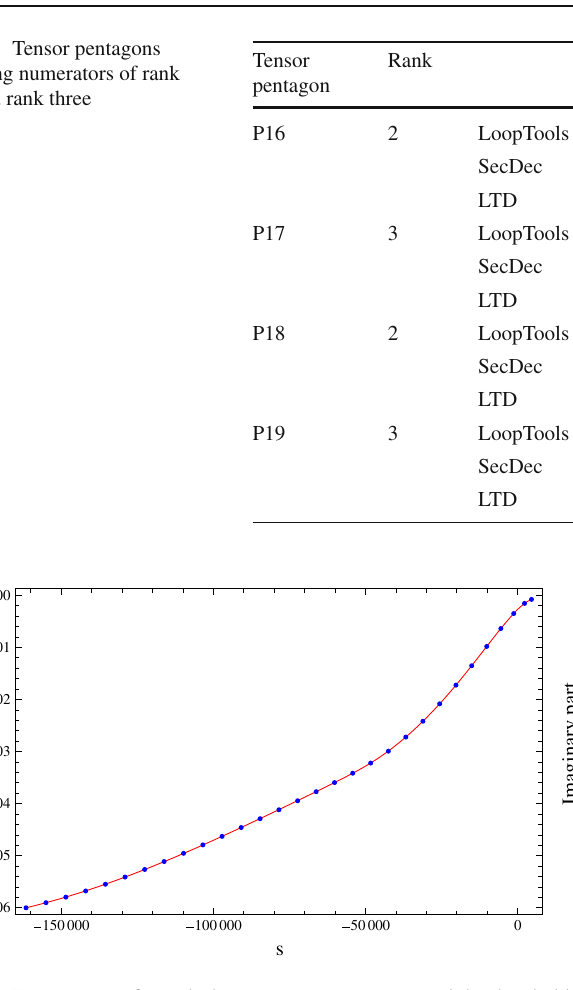
Fig. 10 Energy scan of a rank-three tensor pentagon around the threshold region. The red curve is done with LoopTools and the blue points are obtained with the LTD